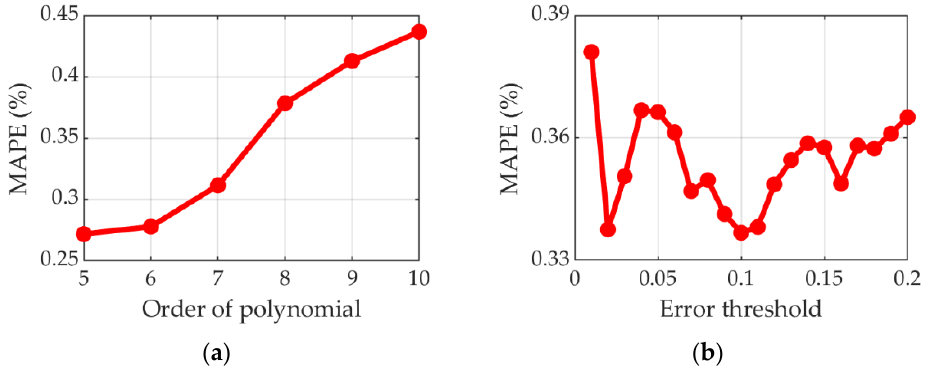
Figure 13. ( a ) The MAPEs with respect to different orders of the polynomial; ( b ) the MAPEs with respect to different error thresholds.